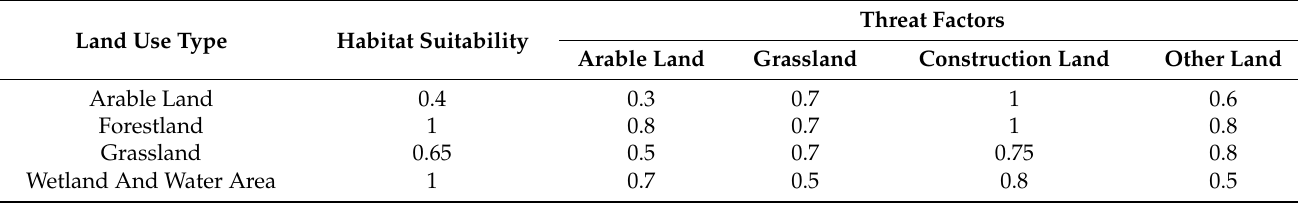
Table 3. Sensitivity of different land use types to threat